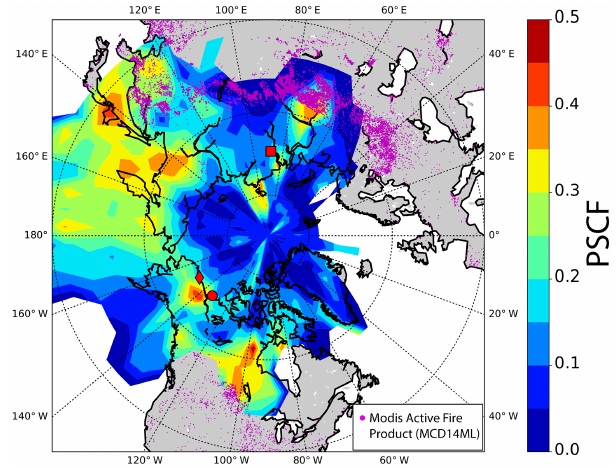
Figure 7. Map showing the PSCF function of N CN , calculated on the basis of concentrations exceeding the 75% percentile. The colour bar indicates the PSCF value and the red dot, the diamond and the square indicate the position of Tuktoyaktuk, Prudhoe Bay (Alaska, USA) and Norilsk (Russia), respectively. The purple dots display the location of active fire spots that occurred between 21 April and 17 May 2014, detected by MODIS (Active Fire Product –